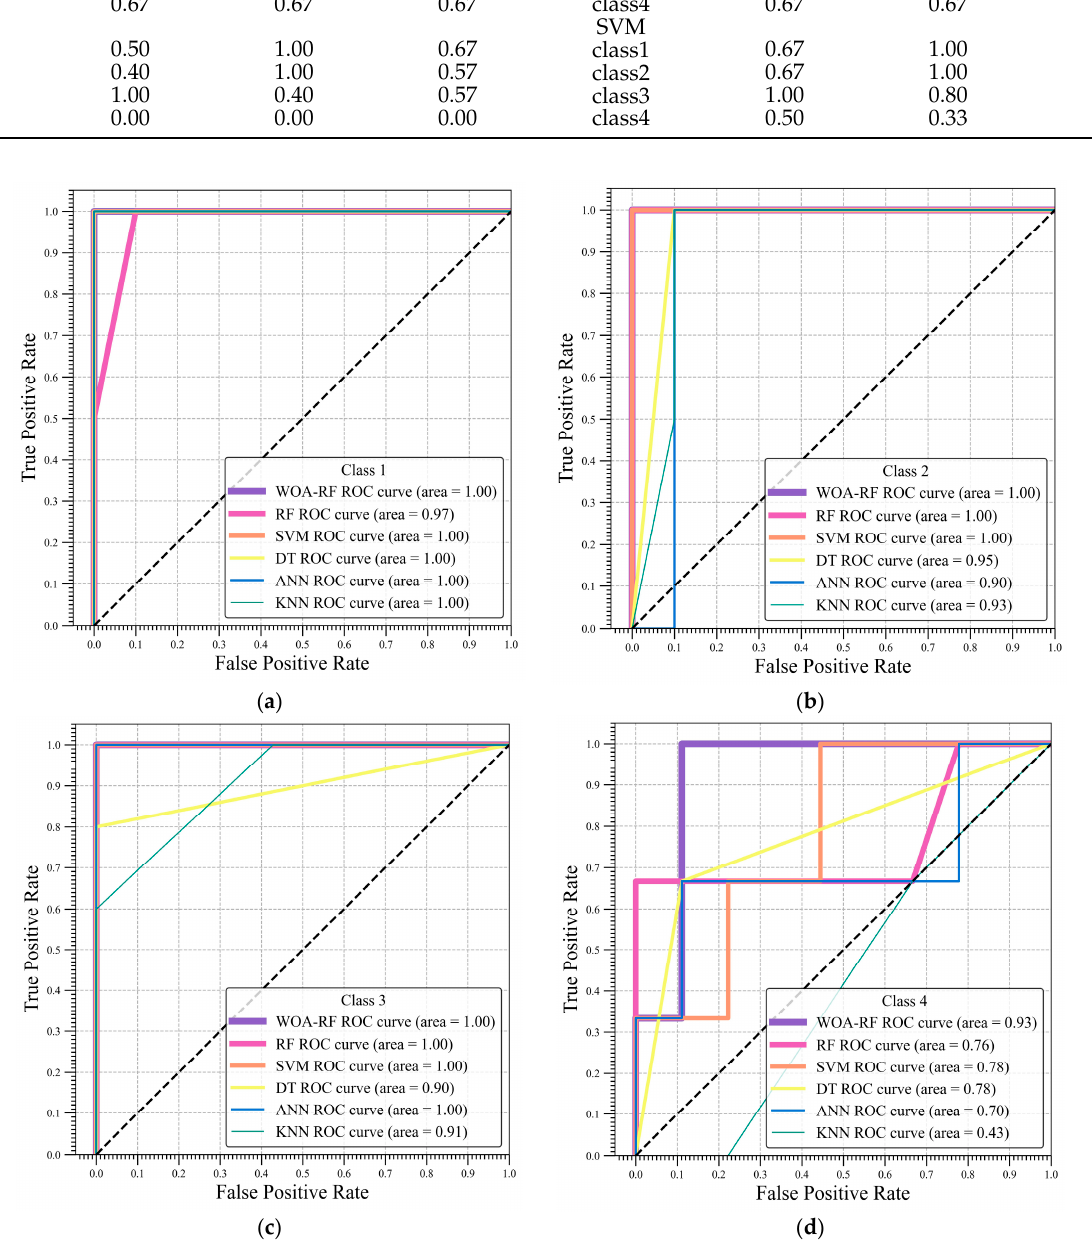
Figure 9. ROC curves and AUC values for different individual classifiers: ( a ) extremely dangerous; ( b ) significant risk; ( c ) greater risk; ( d ) general risk.